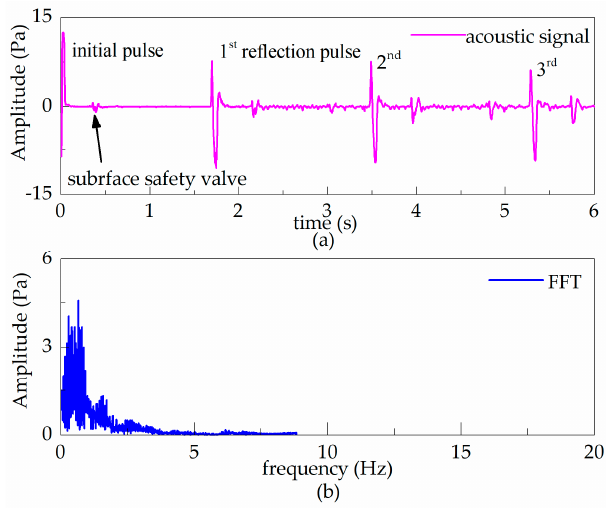
Figure 4. Time domain ( a ) and frequency domain ( b ) of the test acoustic signal.